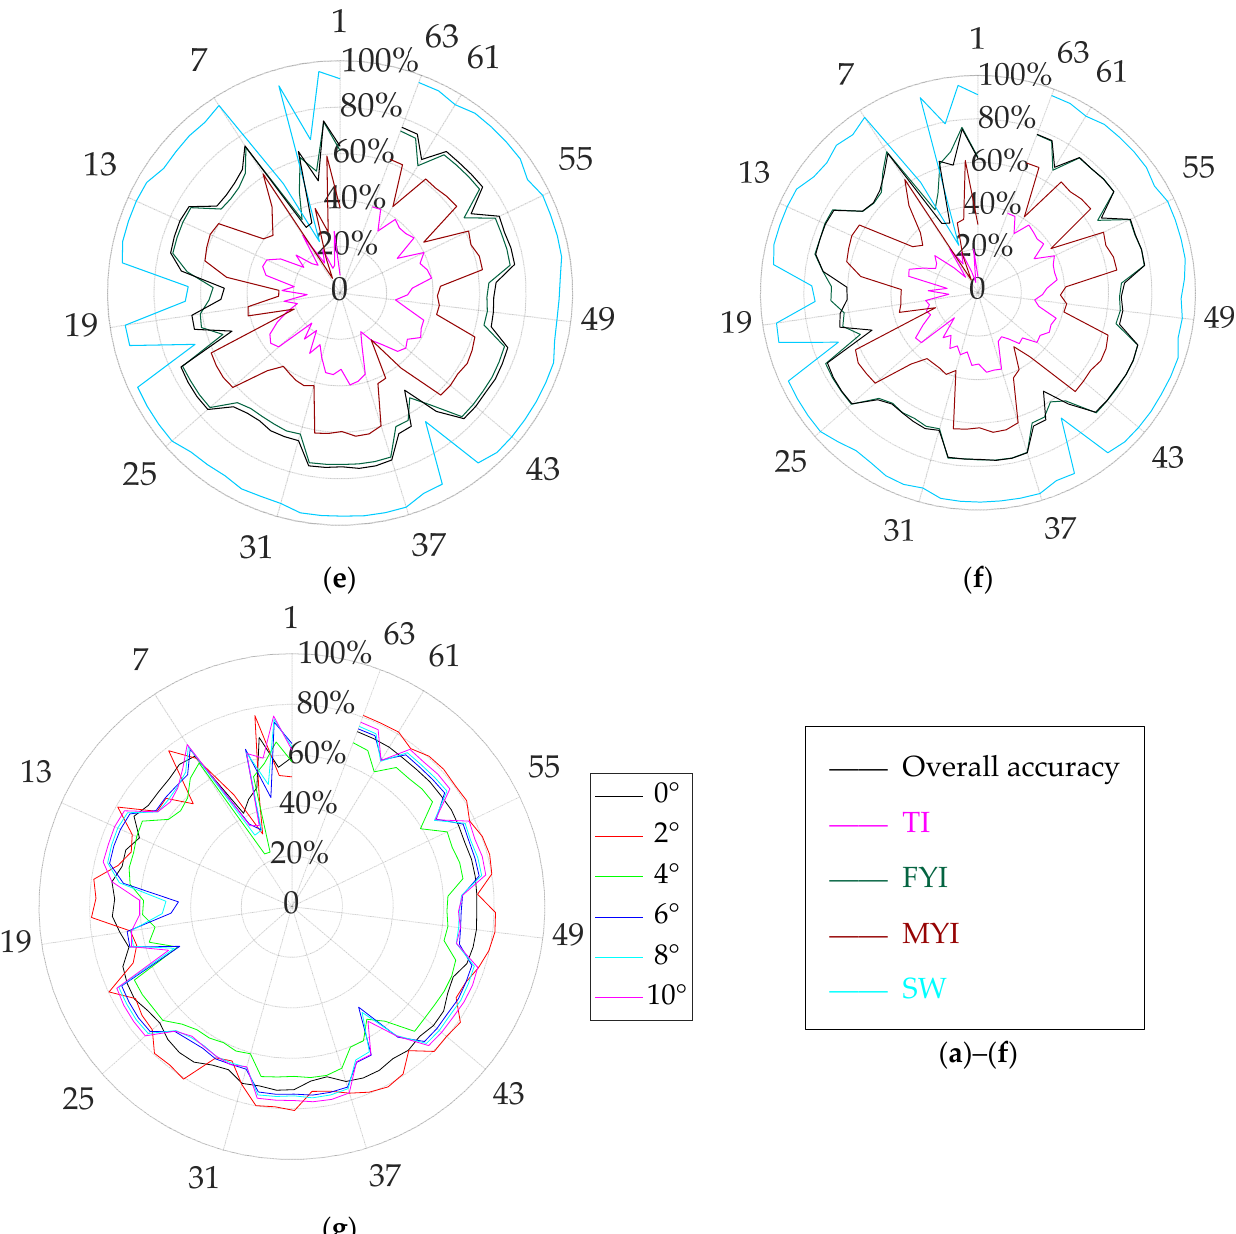
Figure 12. F1 scores and overall accuracies of multifeature combinations for sea ice types and sea water at every small incidence angle. F1 scores: ( a ) 0°; ( b ) 2°; ( c ) 4°; ( d ) 6°; ( e ) 8°; ( f ) 10°. ( g ) Overall accuracies of multifeature combinations at all incidence angles. The numbers represent the order numbers of the multifeature combinations (Table A1). Table 6. Highest F1 scores of sea ice types and sea water at small incidence angles.